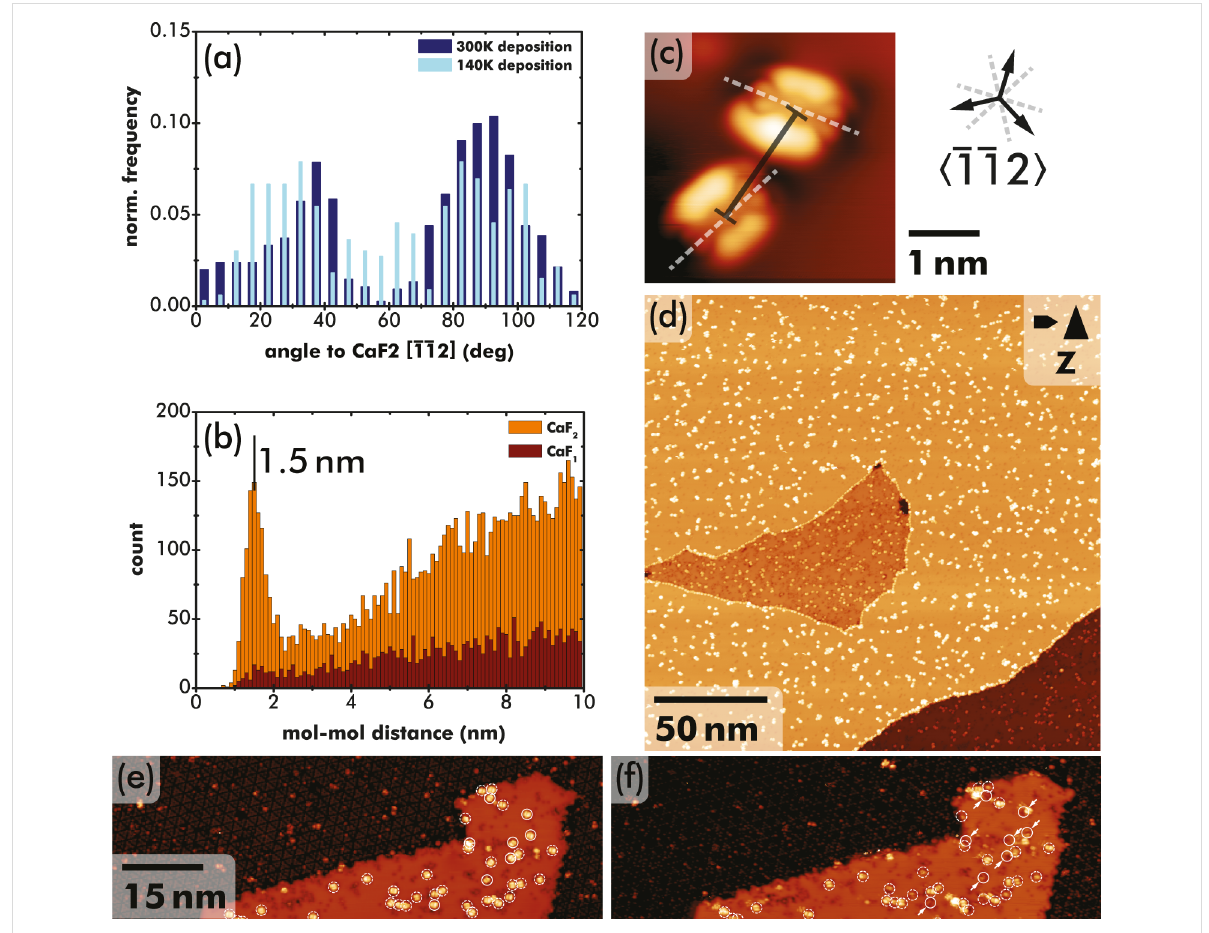
Figure 3: Statistical analysis of (a) the double-lobe orientation on the CaF 1 layer and (b) the nearest-neighbour distance on CaF 1 and CaF 2 /CaF 1 areas. The orientation is determined by the angle between the CaF 2 direction and the axis through the double-lobe structure, see white lines in (c). Nearest-neighbour distances are determined by the molecule–molecule distance measured from centre to centre, see black marker in (c). The to- pography image in (d) presenting PTCDA on a mixed CaF 2 and CaF 1 /Si(111) surface is used for the statistical analysis in (b). STM data acquired on a CaF 1 /Si(111) surface area (e) before and (f) after accidental removal of single PTCDA molecules by the STM tip. Stationary molecules are marked by dashed white circles, removed molecules by solid circles and arrows in